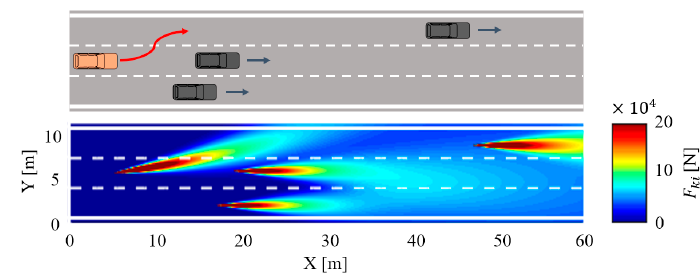
Figure 4. The time-varying traffic risk map. The three black vehicles are driving straight along the road lane. The orange vehicle follows the black vehicle in the second lane and is changing to the left lane.